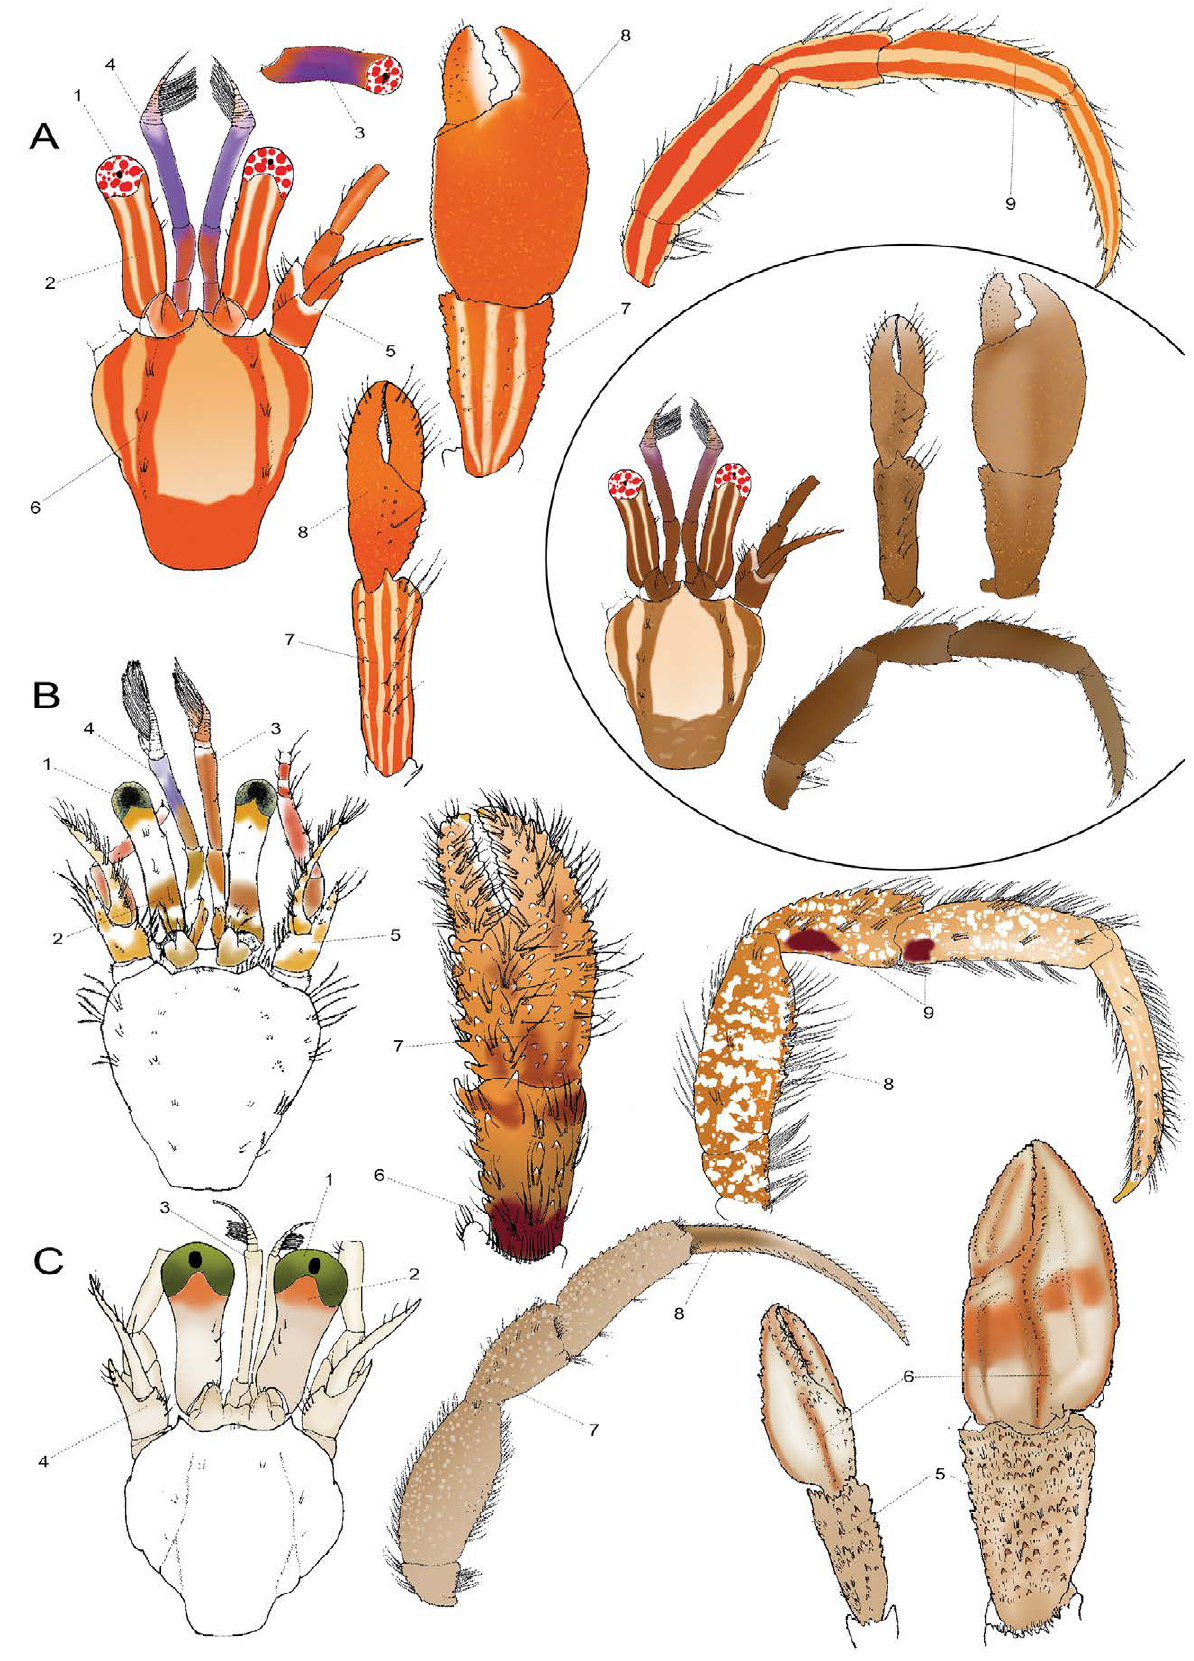
Fig. 9. – Colour patterns of Pagurus species: P. chevreuxi , Atlantic variety (A, 1-9); circled area corresponds to variations observed in Mediterranean specimens; P. cuanensis ; (B, 1-9); P. excavatus (C, 1-8). All vectorial drawings modified from Ingle